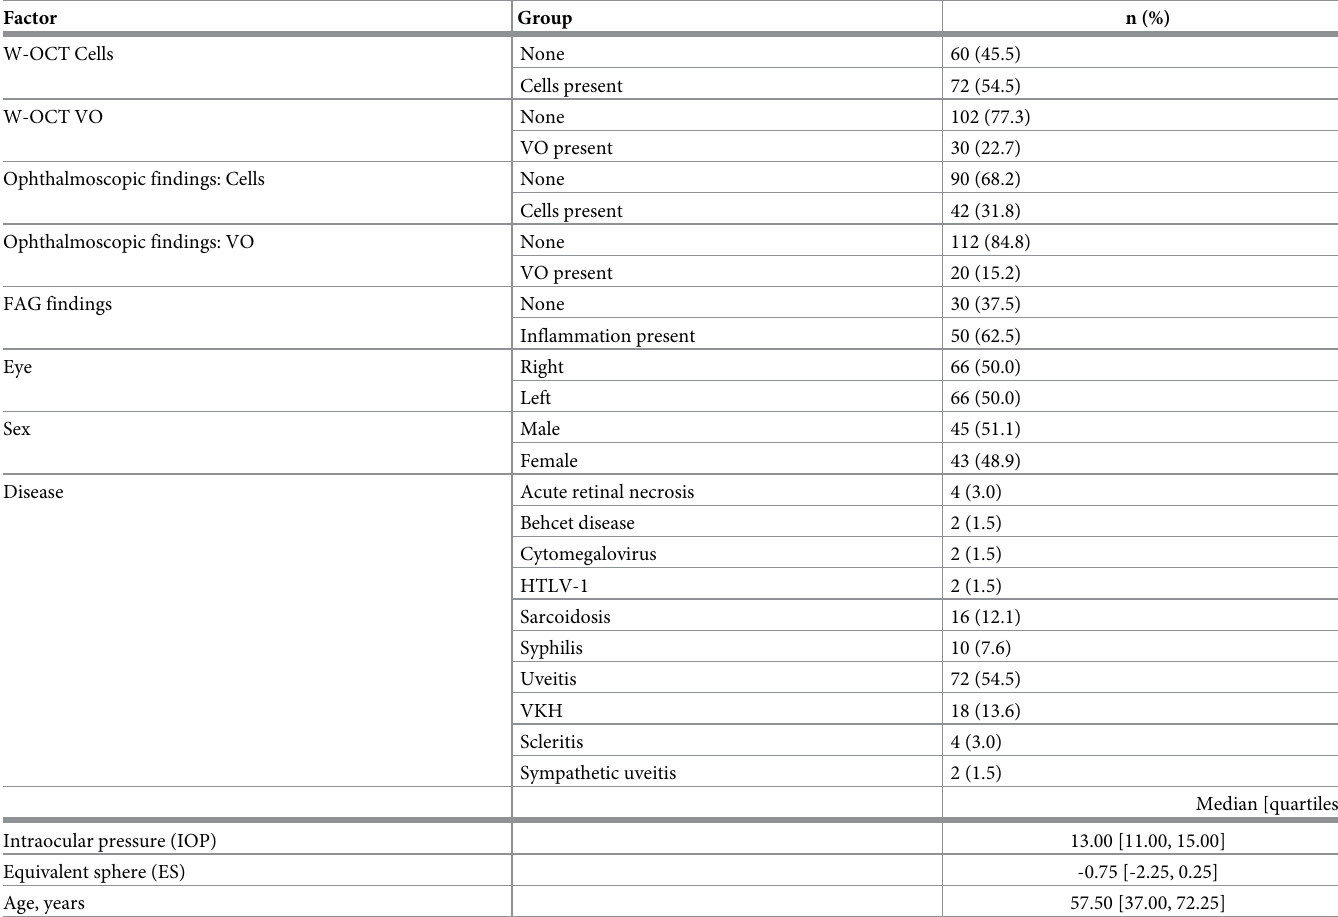
Table 1. Characteristics of all patients. IOP, ES, and age are shown as median and quartiles and were compared using the χ 2